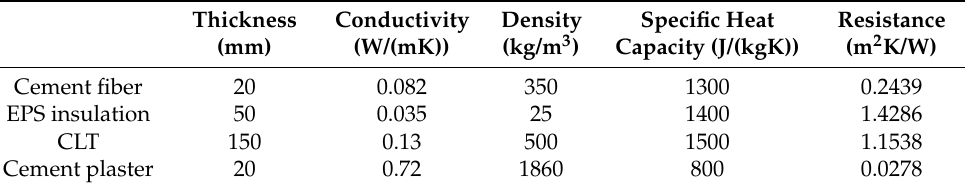
Table 5. Details of CLT external wall design in